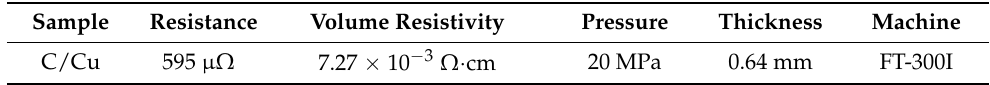
Table 1. Electrical resistivity of the carbon-coated copper powder. Sample Resistance Sample